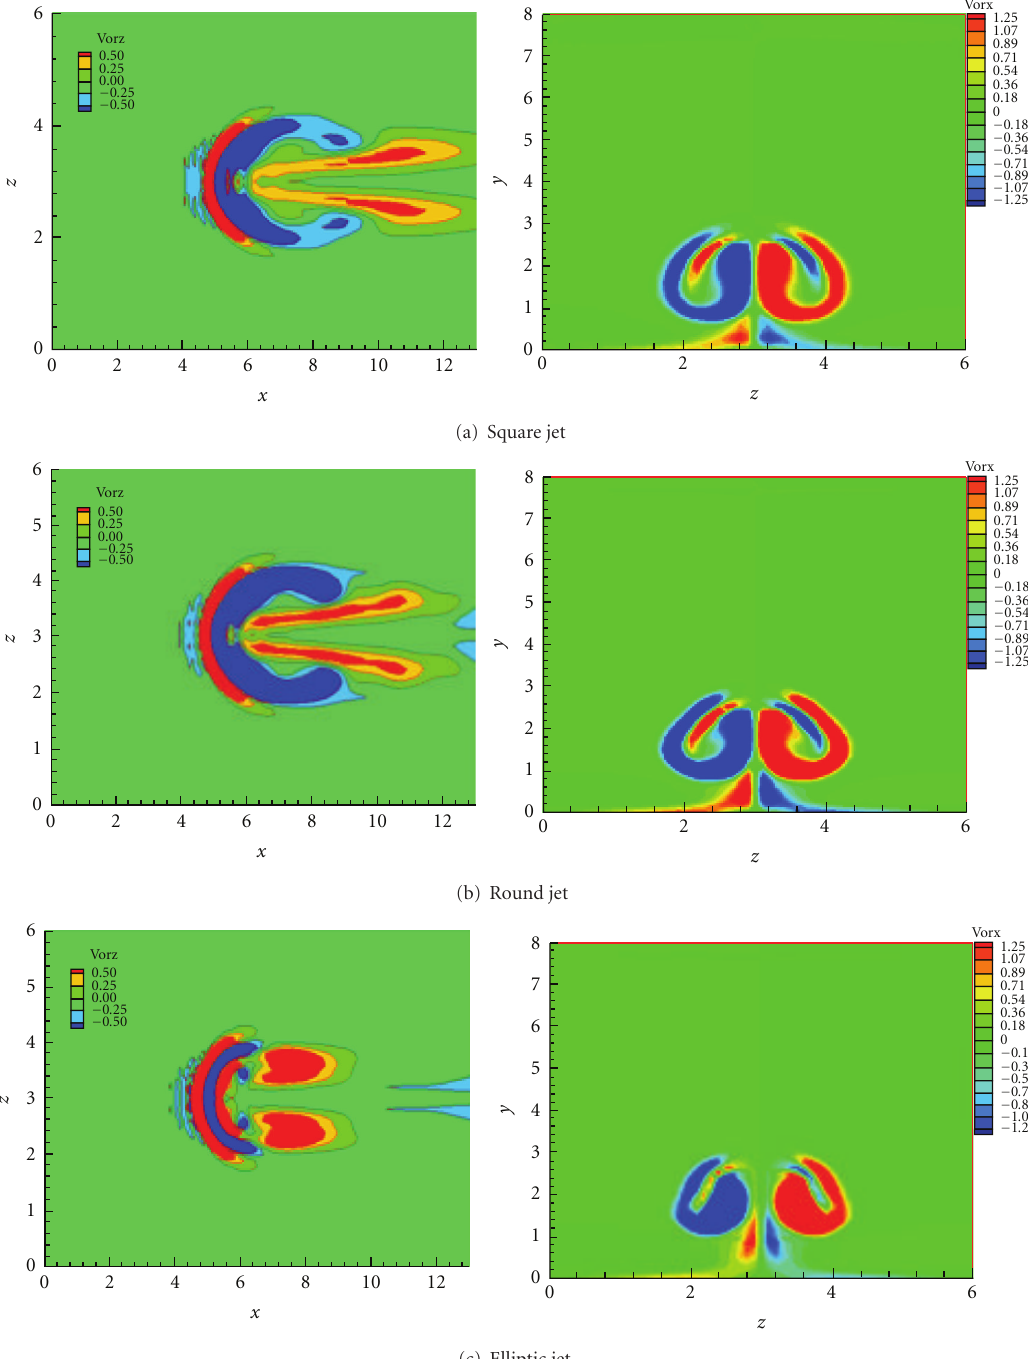
Figure 5: Simulated ω z contours at y = 1 . 8D (left) and ω x contours at x = 6 . 5D (right).